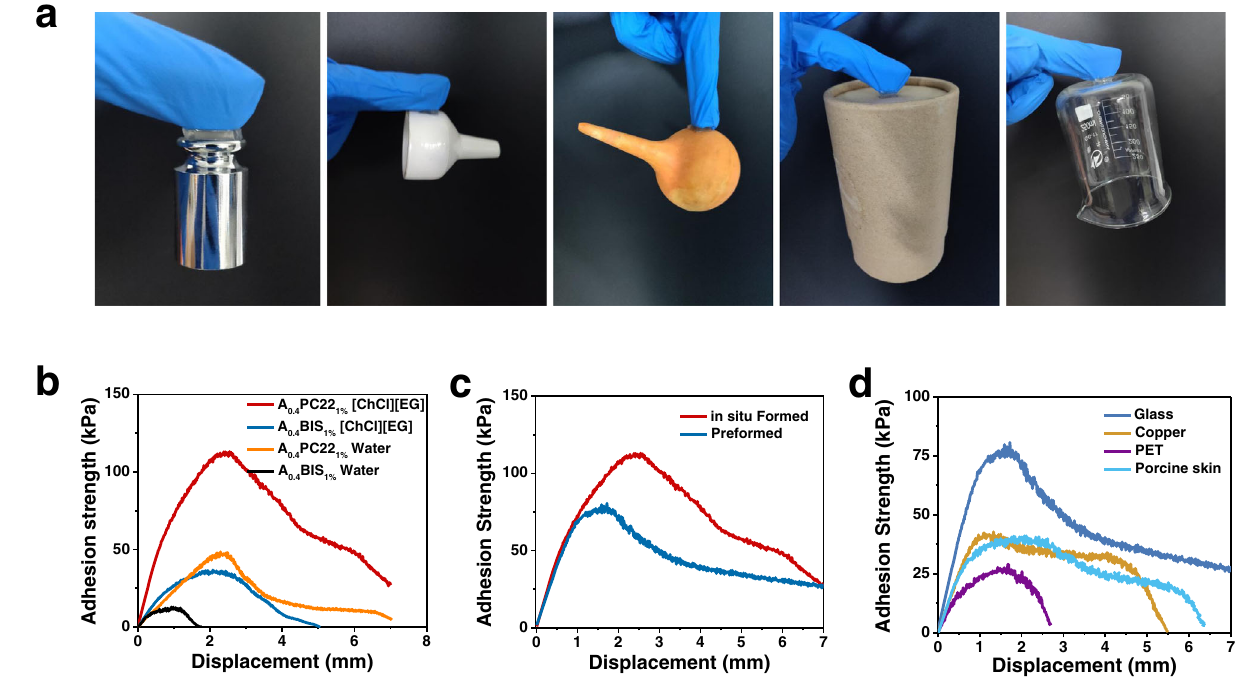
Fig. 5 | Adhesive properties of gels. a Sticking and lifting of a weight (100g), a Buchner funnel (~60g),a suction bulb(~32g),a box(~102g), and a beaker (~109g) with A 0.4 PC22 1% [ChCl][EG] gel. The mass of the gels was ~0.27g. b Sheer peeling